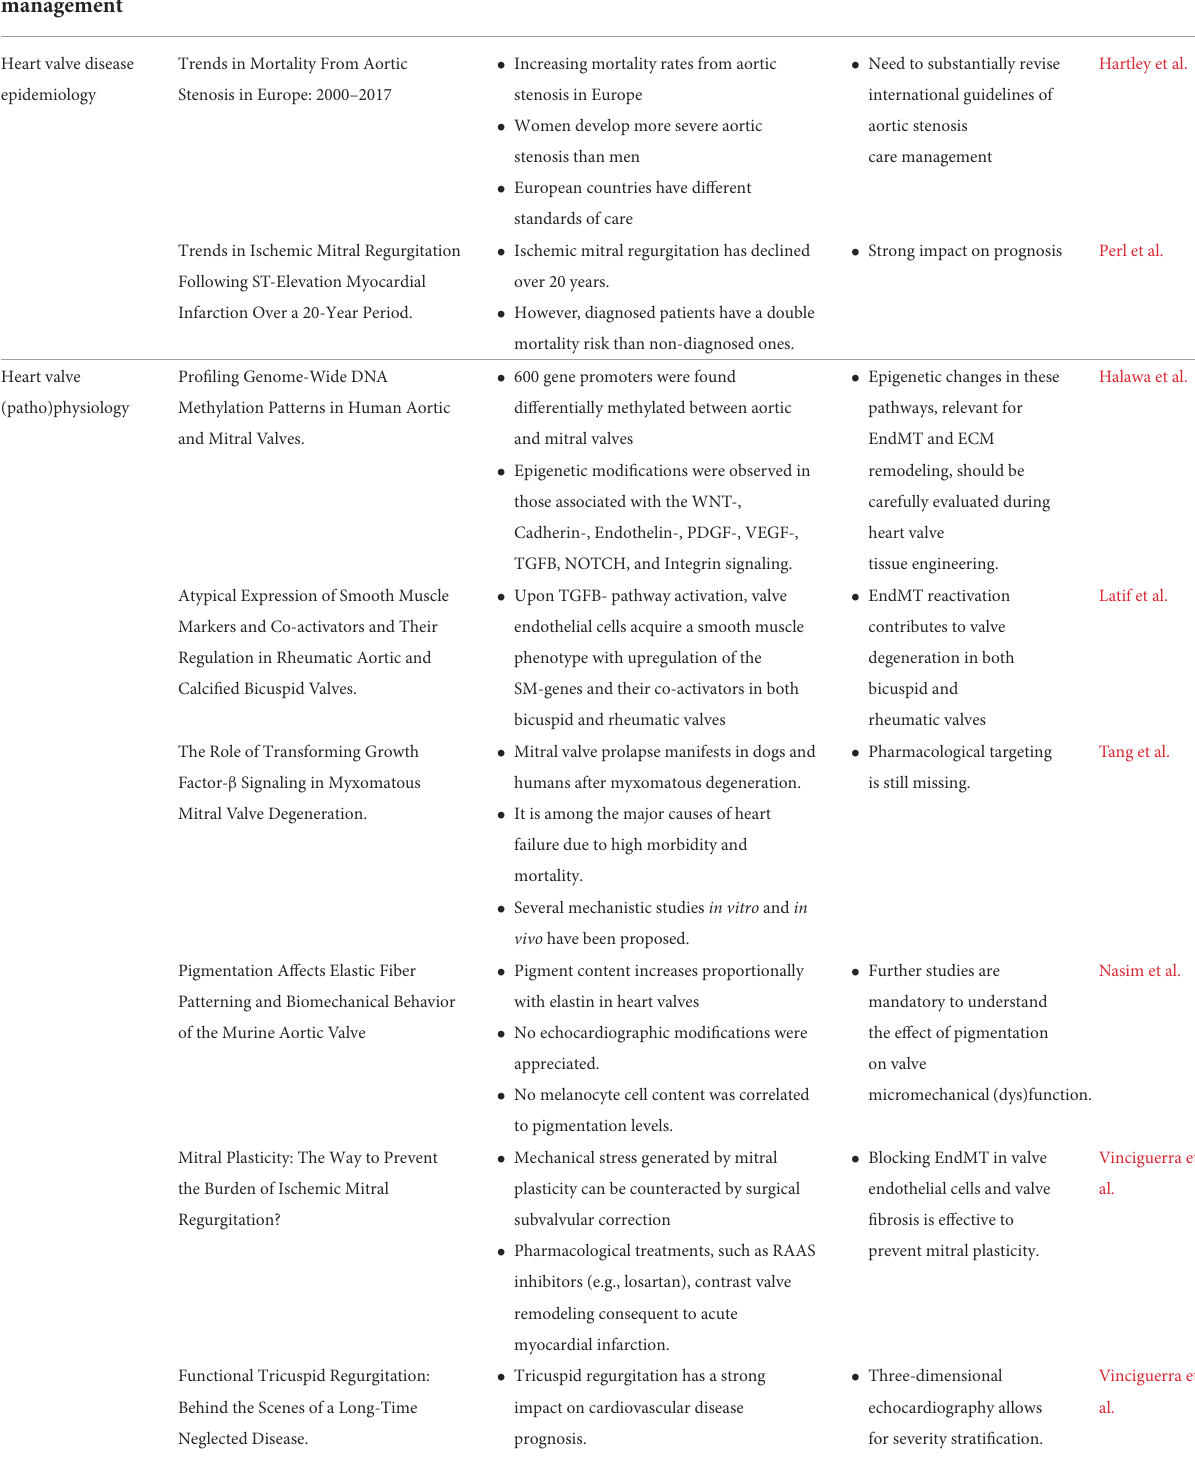
TABLE 1 Take-home messages from the Research Topic ‘Insight in heart valve disease: